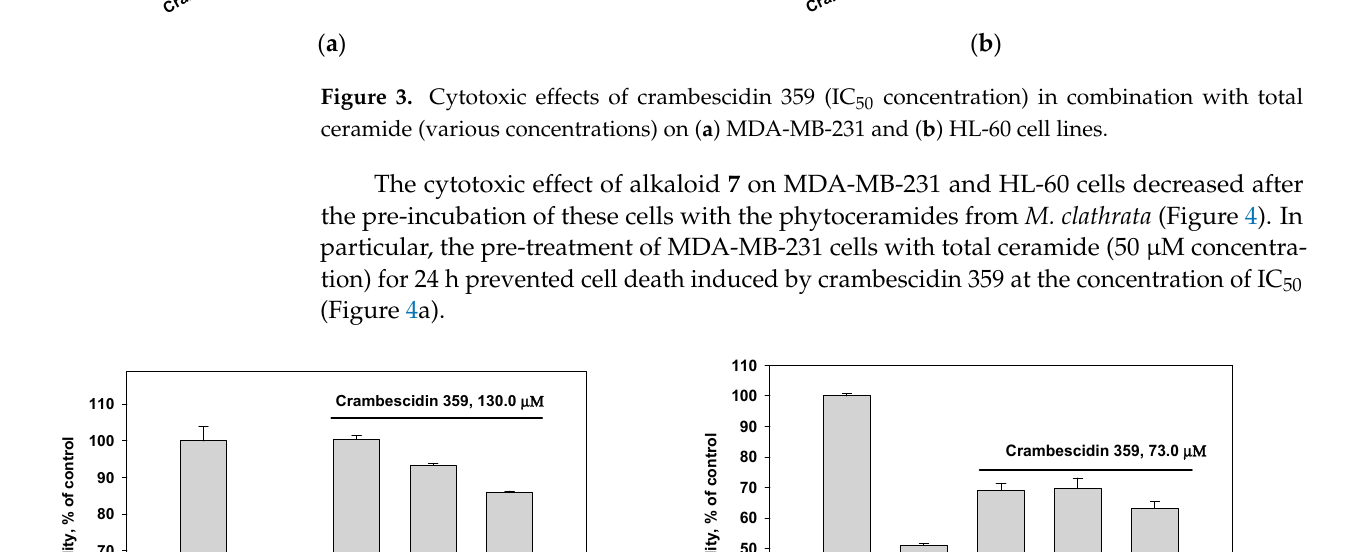
Total ceramide, μ M